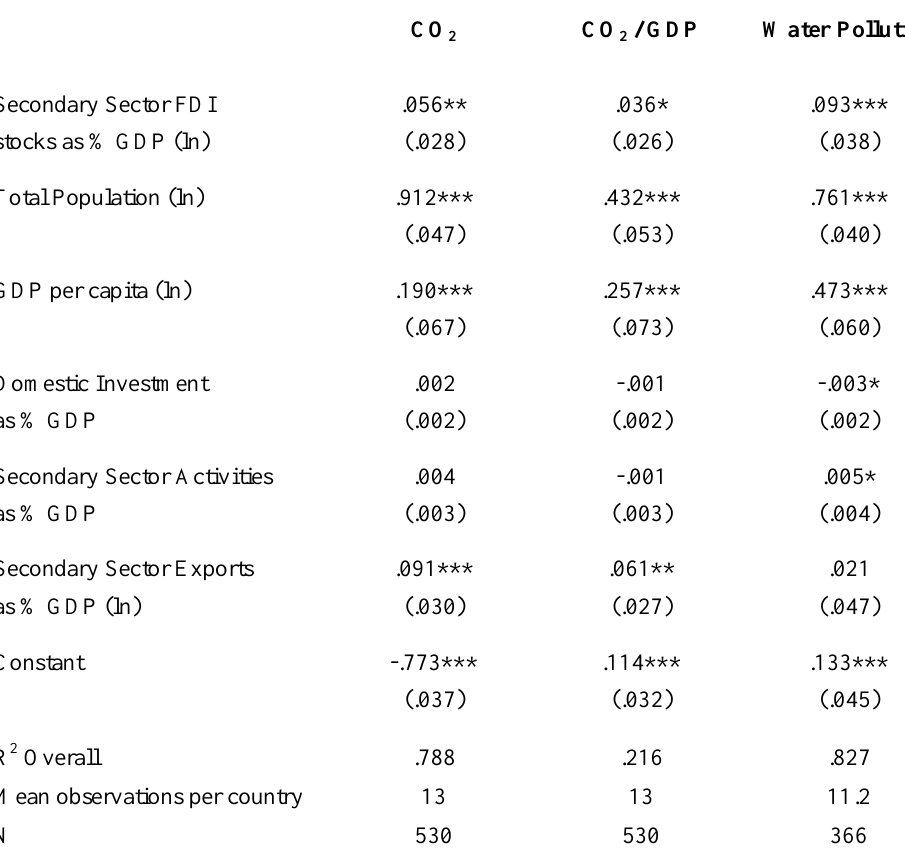
Table 2. Unstandardized Coefficients for the Fixed Effects Regression of Carbon